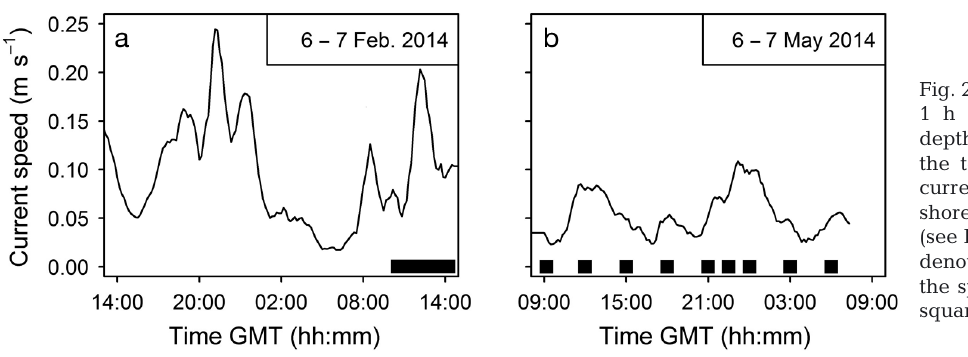
Fig. 2. Current speed (smoothed 1 h running average) at 1 m depth at (a) the spatial and (b) the temporal survey sites. The current meter was closer to the shore at the temporal survey